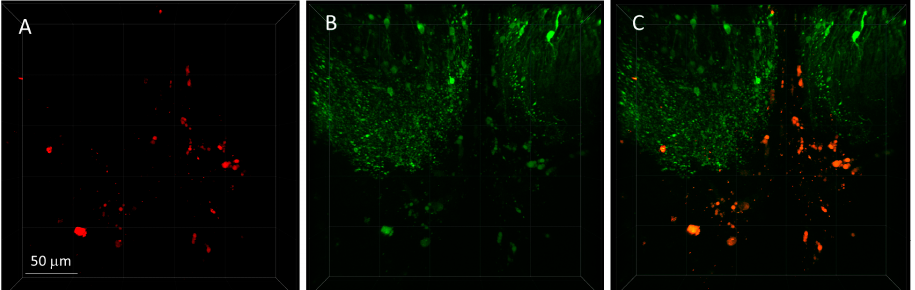
Figure 6. Fluorescent image of bionanoprobe clusters. ( A ) Fluorescence of DsRed protein on nanoprobes measured at 950 nm. ( B ) Fluorescence of gold nanoparticles measured at 850 nm. ( C ) Combined. Images collected on a 3i/Zeiss two-photon upright microscope. The excitation wavelength was 950 nm. A 3 µL volume of a solution containing DsRed-AuBP (size 15 nm) bionanoprobes was injected into the ventral diencephalon area of a viable zebrafish brain.